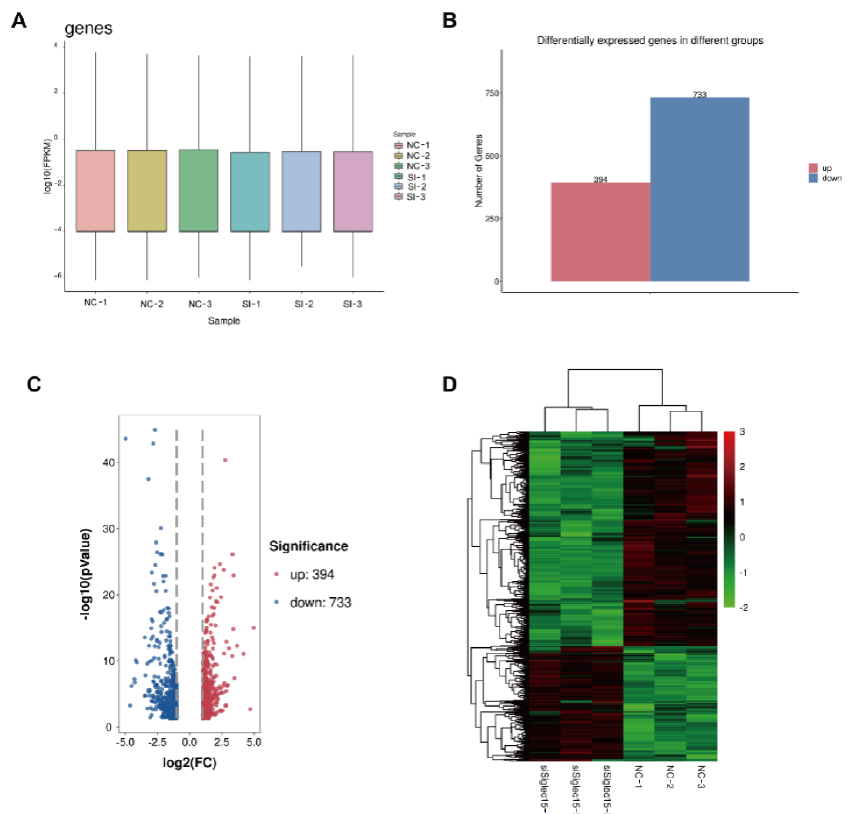
Figure 6. RNA-seq analysis in GCTB stromal cells with Siglec-15 knockdown. ( A ) The RNA intensities for samples were nearly the same after normalization by box plots. ( B ) The differentially expressed genes between the siRNA group and NC group are shown by a histogram. ( C ) The distribution of differentially expressed genes between the NC group and siRNA group is shown by a volcano diagram. ( D ) Highly consistent transcriptional changes were exhibited by heatmaps with three replicates of the NC group and siRNA group.